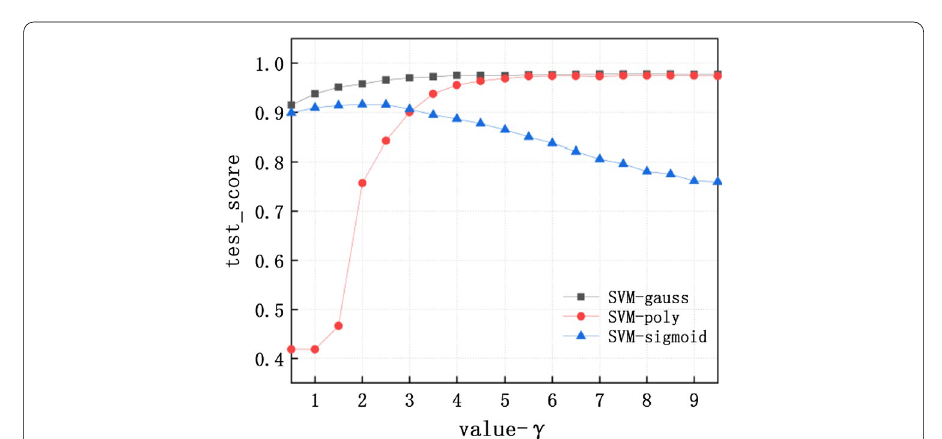
Fig. 14 The classification accuracy of SVM on testing set with different kernel and value of